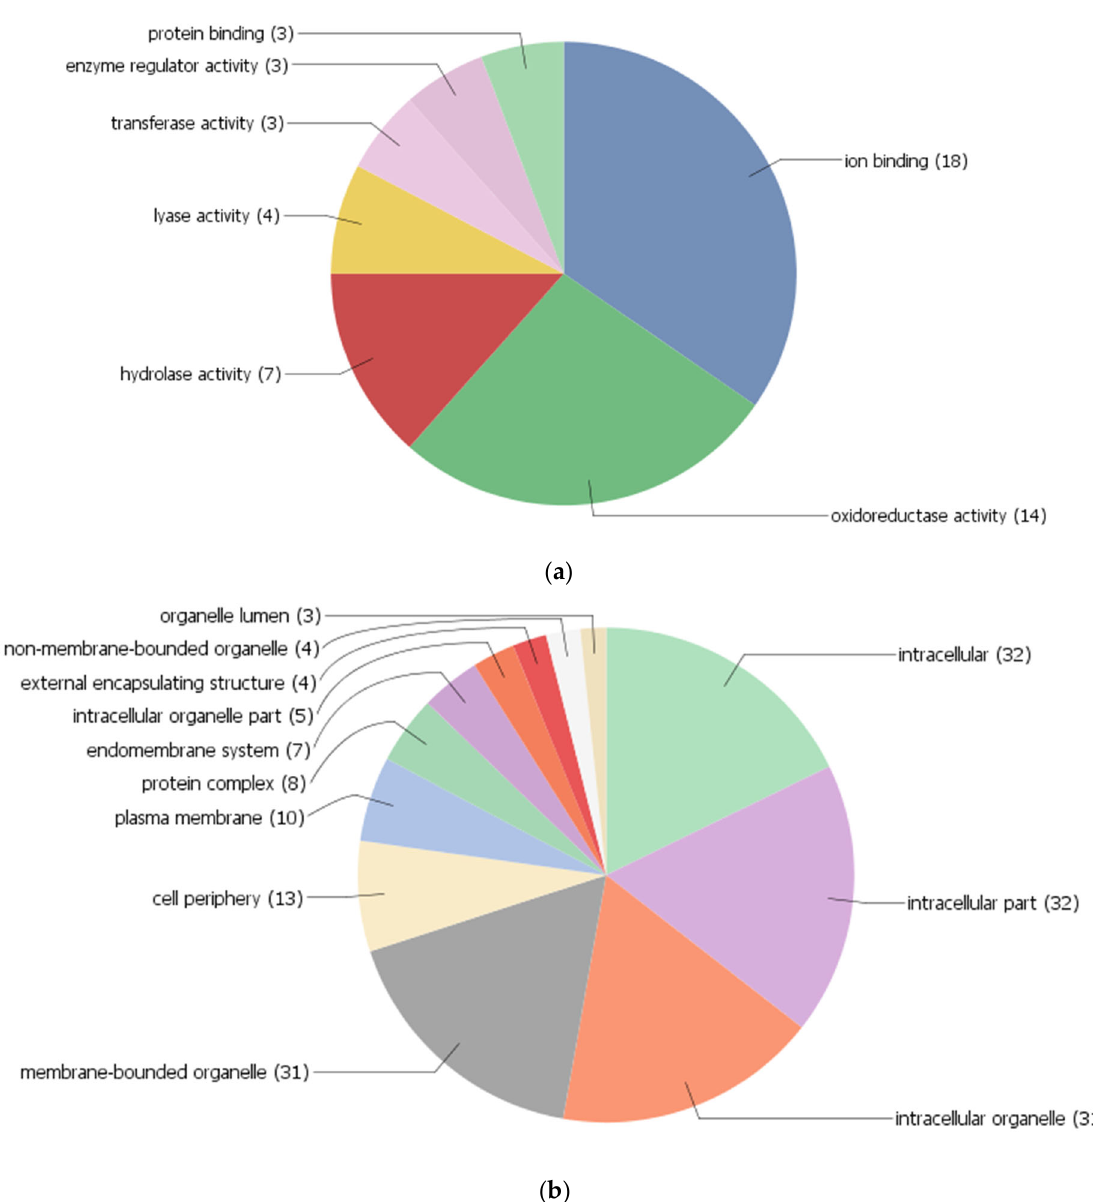
genes classified in respective GO categories (FDR corrected p value ≤ 0.01).